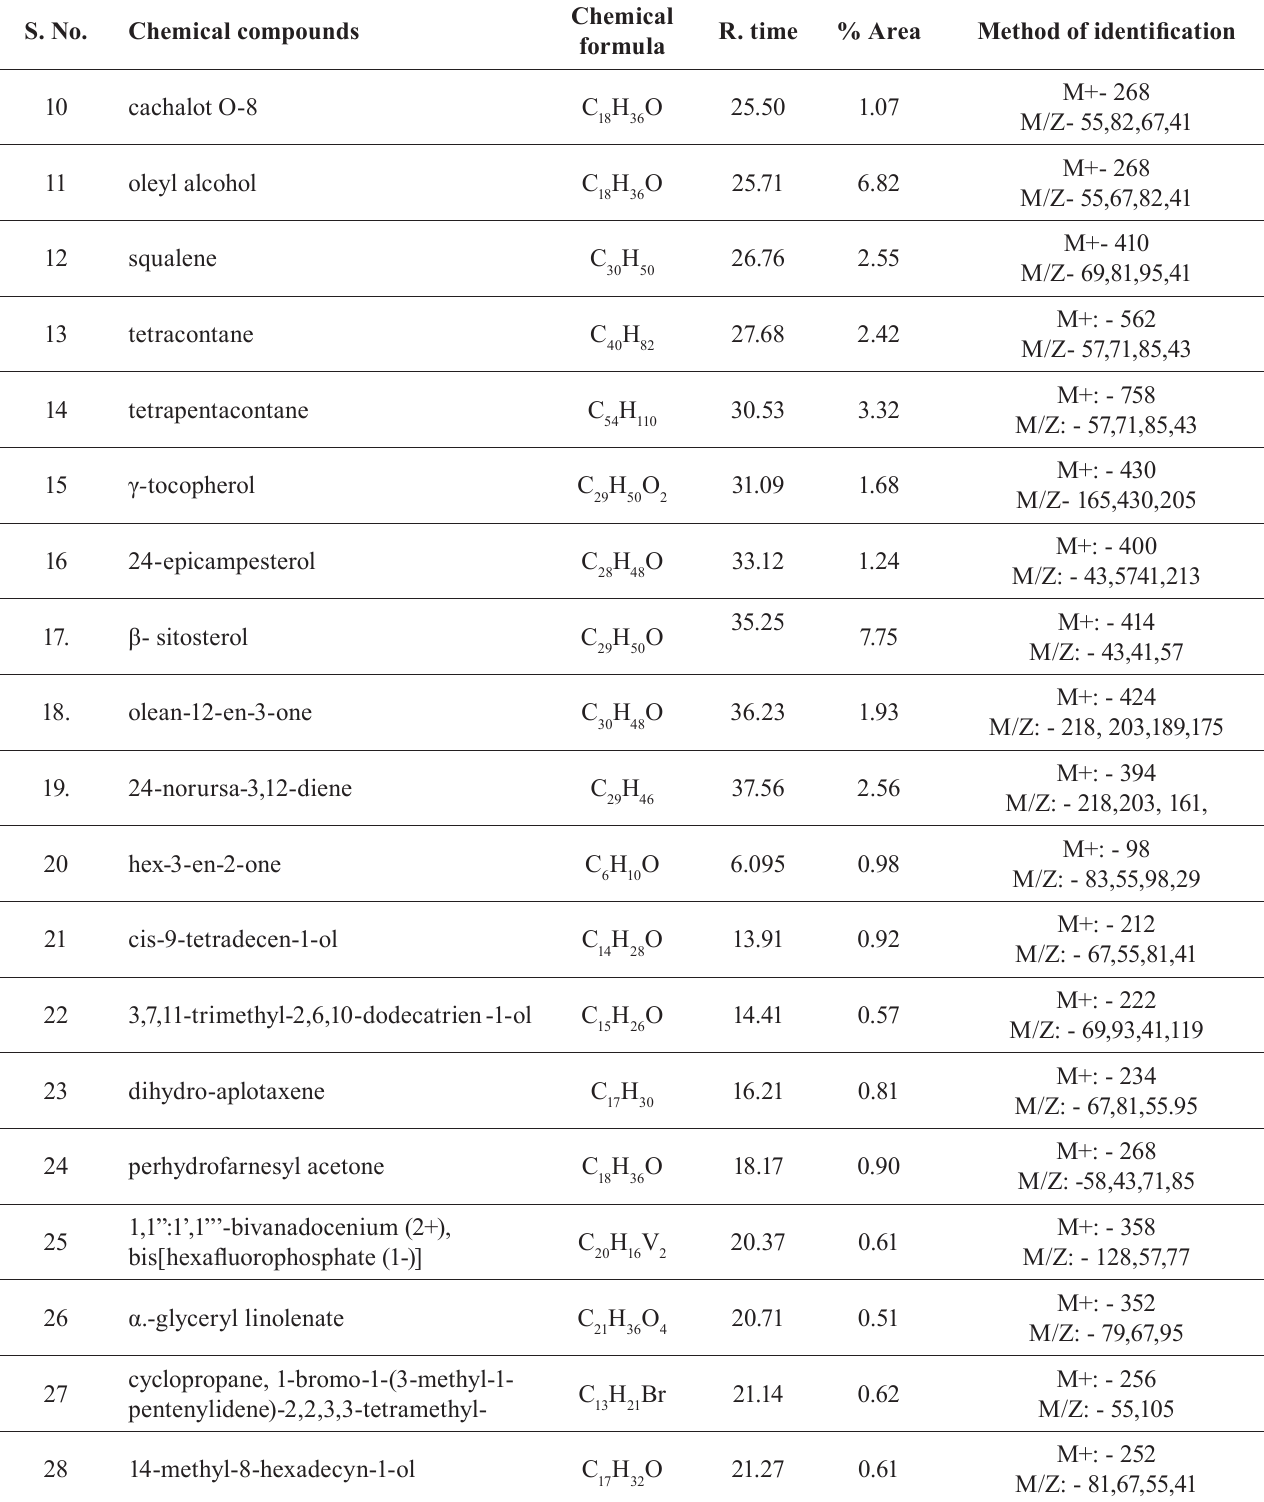
TABLE I - C hemical composition of hexane extract of whole plant of A. uliginosa